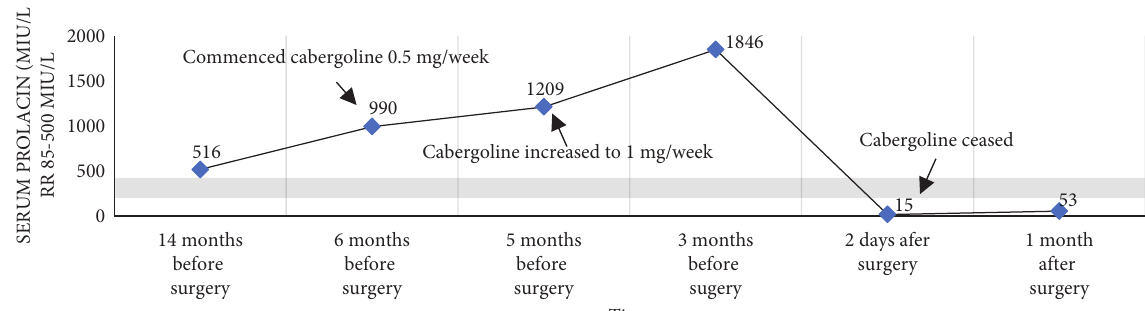
Figure 1: Prolactin levels before and after surgery in this case.